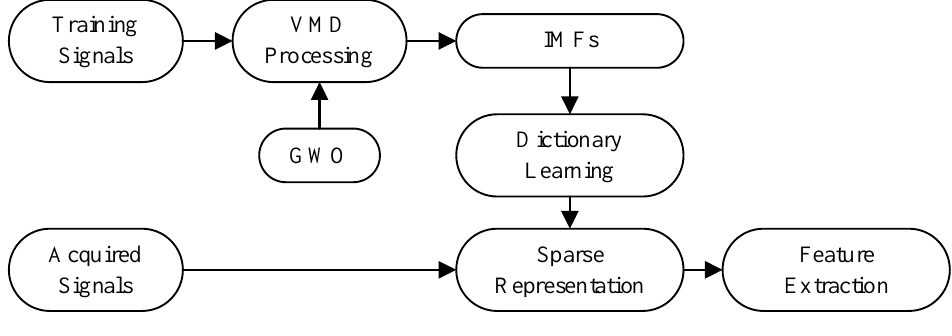
Figure 1. Condition-monitoring scheme.